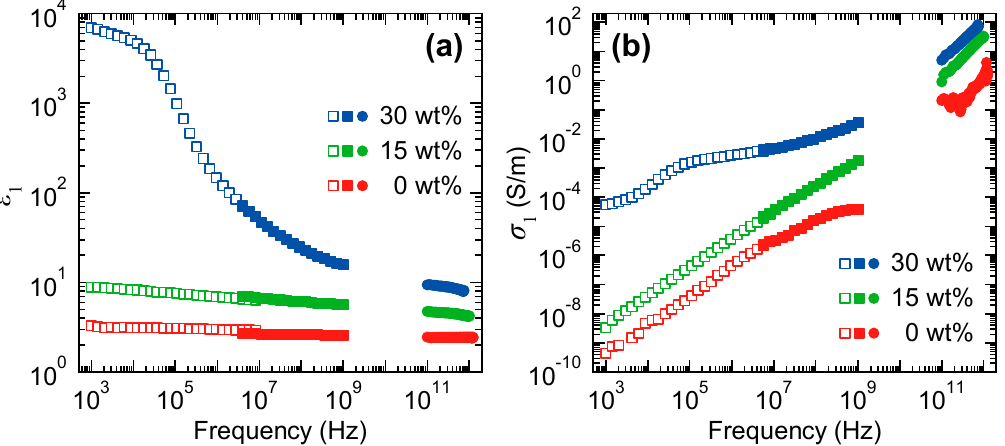
Figure 7. Frequency dependence of the real part of ( a ) the dielectric function and ( b ) the conductivity for the SBR samples with different CB amounts of 0 (red symbols), 15 (green symbols) and 30 wt % (blue symbols). The filled and open squares correspond to the data measured by two impedance analyzers with different measuring ranges and the filled circles correspond to those obtained by the THz-TDS measurements. Reproduced from Ref. [43] with the permission of AIP publishing (License Number: 4457780180478).